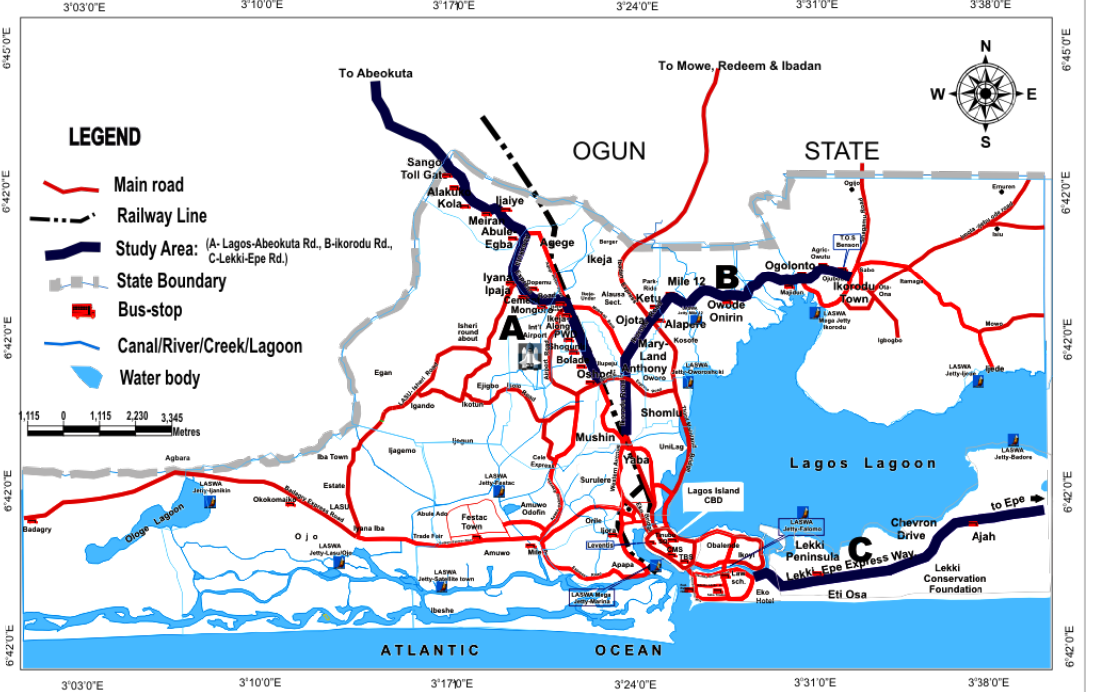
Source : modified from LAMATA,